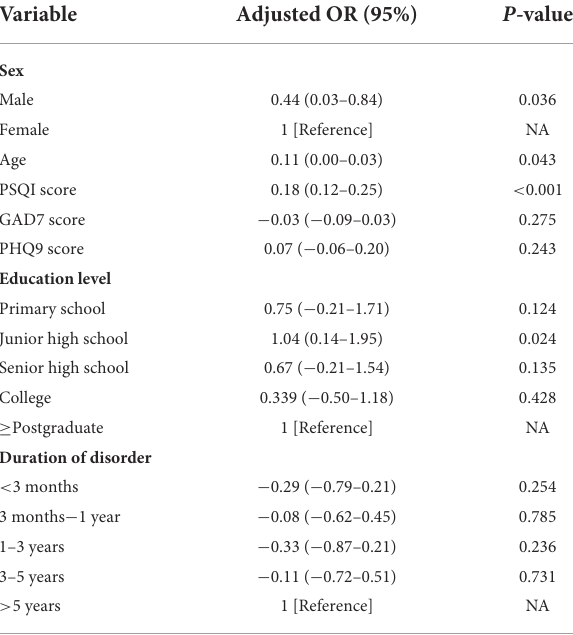
TABLE 4 Risk factors for delayed response to insomnia treatment according to multivariate logistic regression analysis.